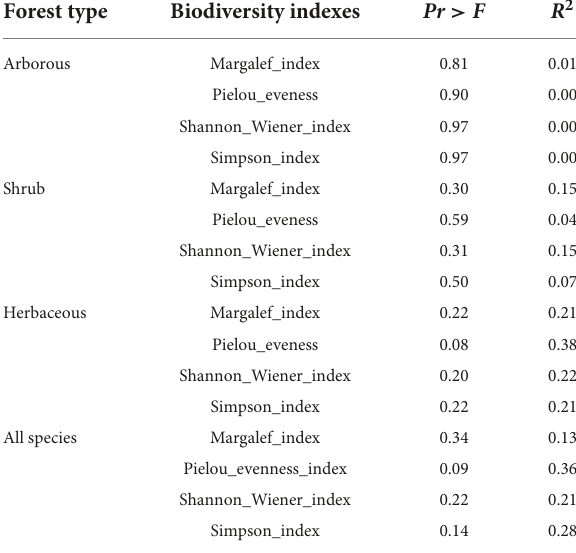
TABLE 5 Effect of the Moso bamboo invasion on the relationships between aboveground biomass and biodiversity indexes in each layer and the whole stand comprised of three layers ( N = 9 in each